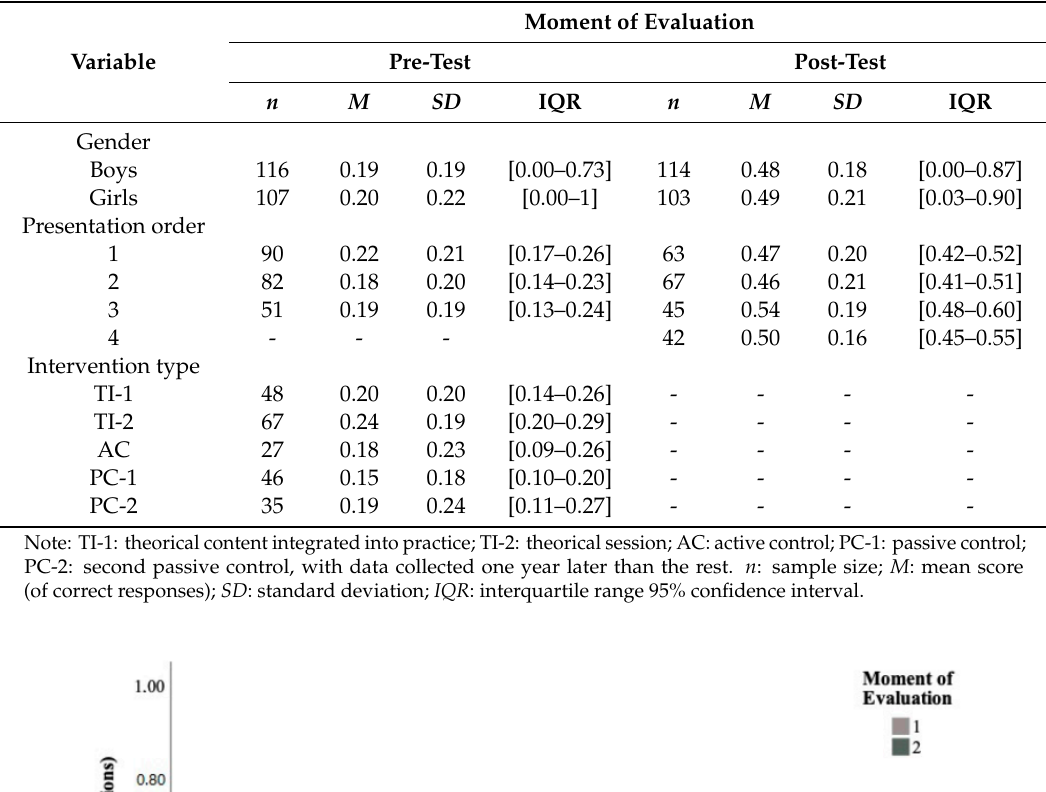
Table 2. Means and standard deviations of preliminary analyses: Correct responses in the pre- and post-test as a function of gender, presentation order, and intervention type.